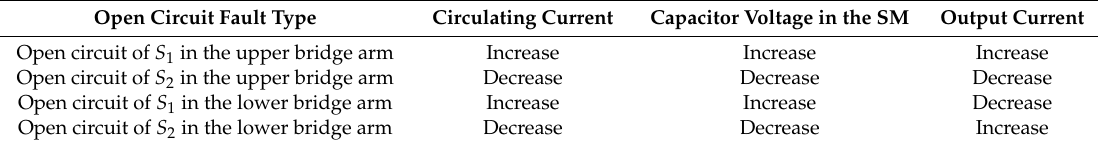
Table 4. The relationship between the opening fault type and the circulation and the output current